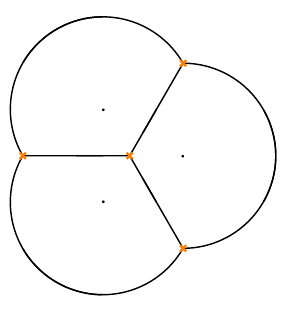
Figure 1. The BPS graph of N = 2 SQCD, i.e. the SU(2) gauge theory with N f = 4 fundamental hypermultiplets. The UV curve C is given by a sphere with four punctures, one of which is placed at in(cid:12)nity. The BPS graph G decomposes C into four regions, each one is a punctured